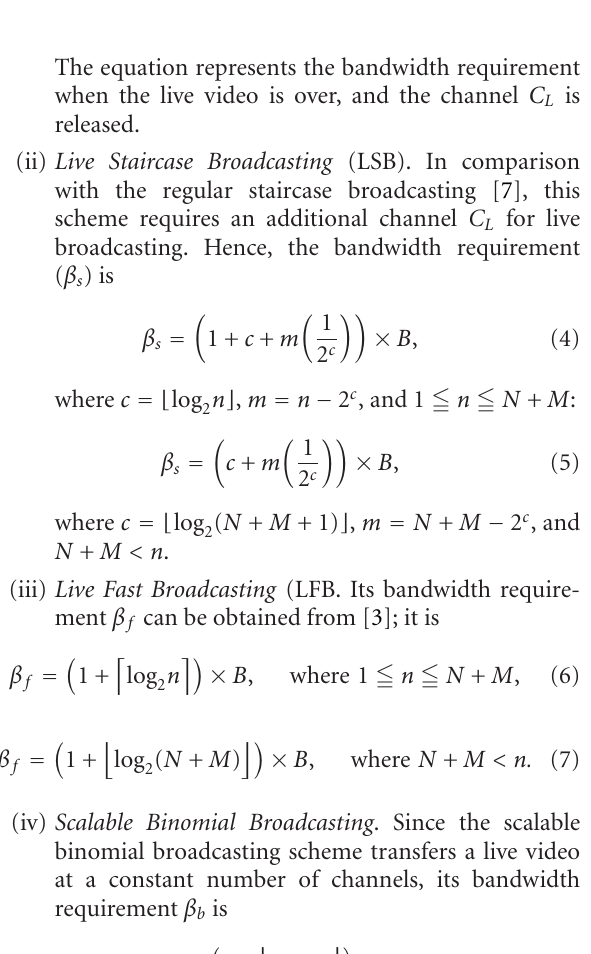
Figure 6: The scalable binomial broadcasting scheme.